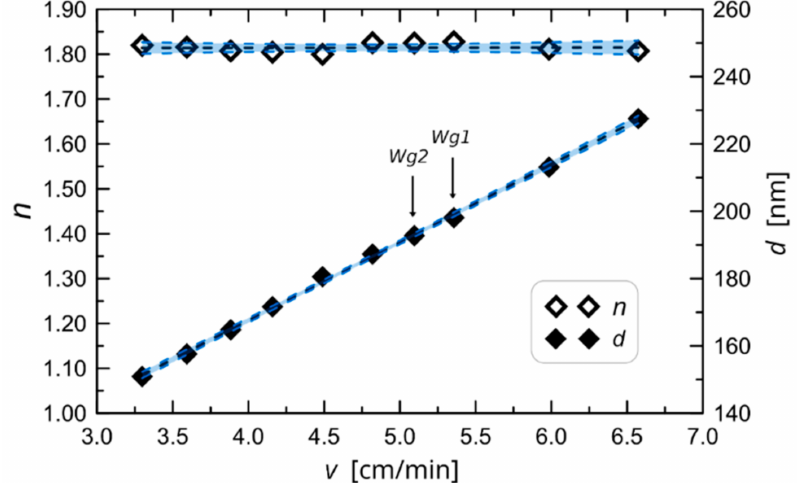
Figure 2. The experimentally determined characteristic of waveguide film thickness d and refractive index n against change in substrate withdrawal speed from the sol v .